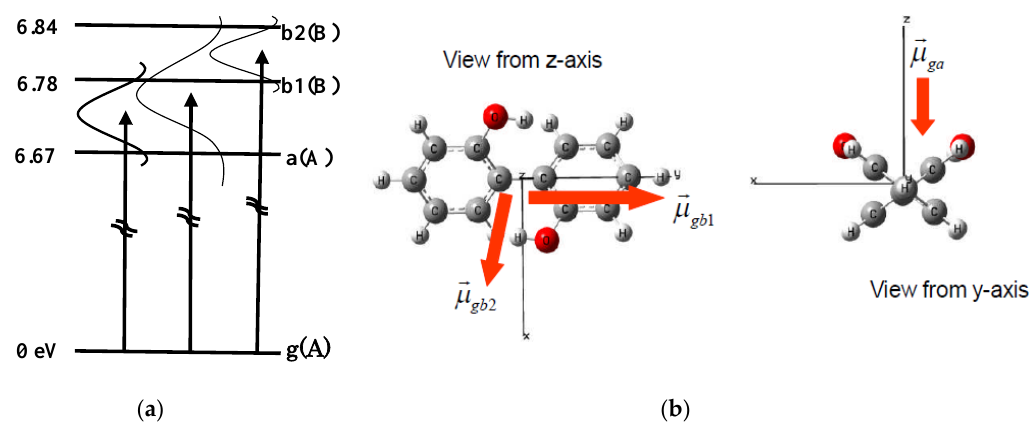
Figure 9. ( a ) Three electronic excited states and optical excitations to create three types of the electronic coherence of ( P )-2,2′-biphenol ( b ) The geometrical structure and the electronic transition moment vectors. Modified from [87] with permission of the American Institute of Physics. The transition energies to the a (A), b 1 (B), and b 2 (B) states, which were calculated at the